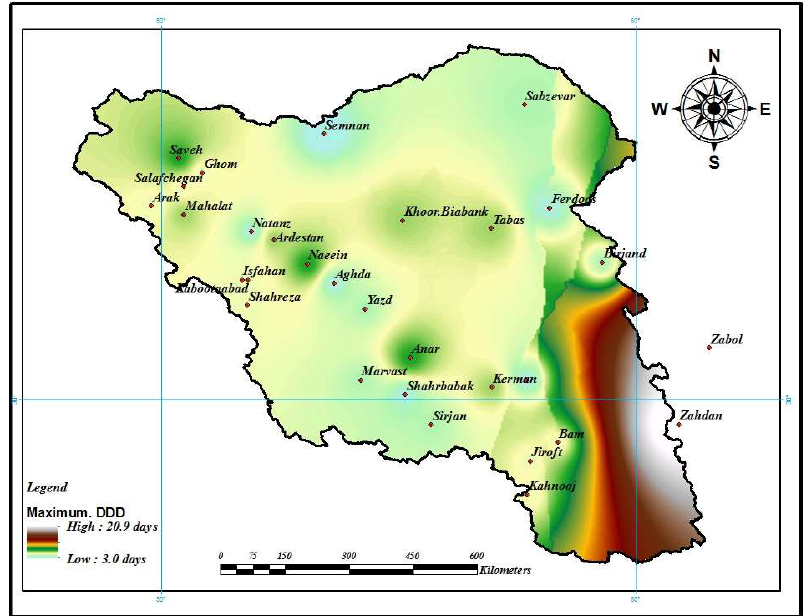
Figure 10. Maximum dust day duration in the study area.